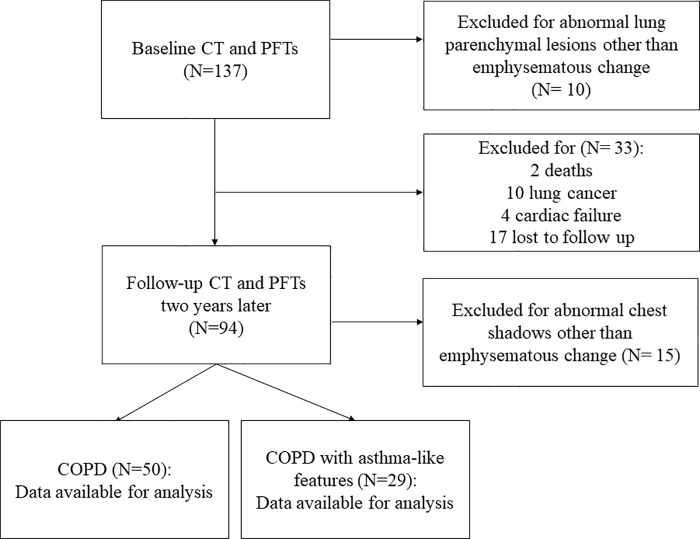
Flow chart of the study participants.